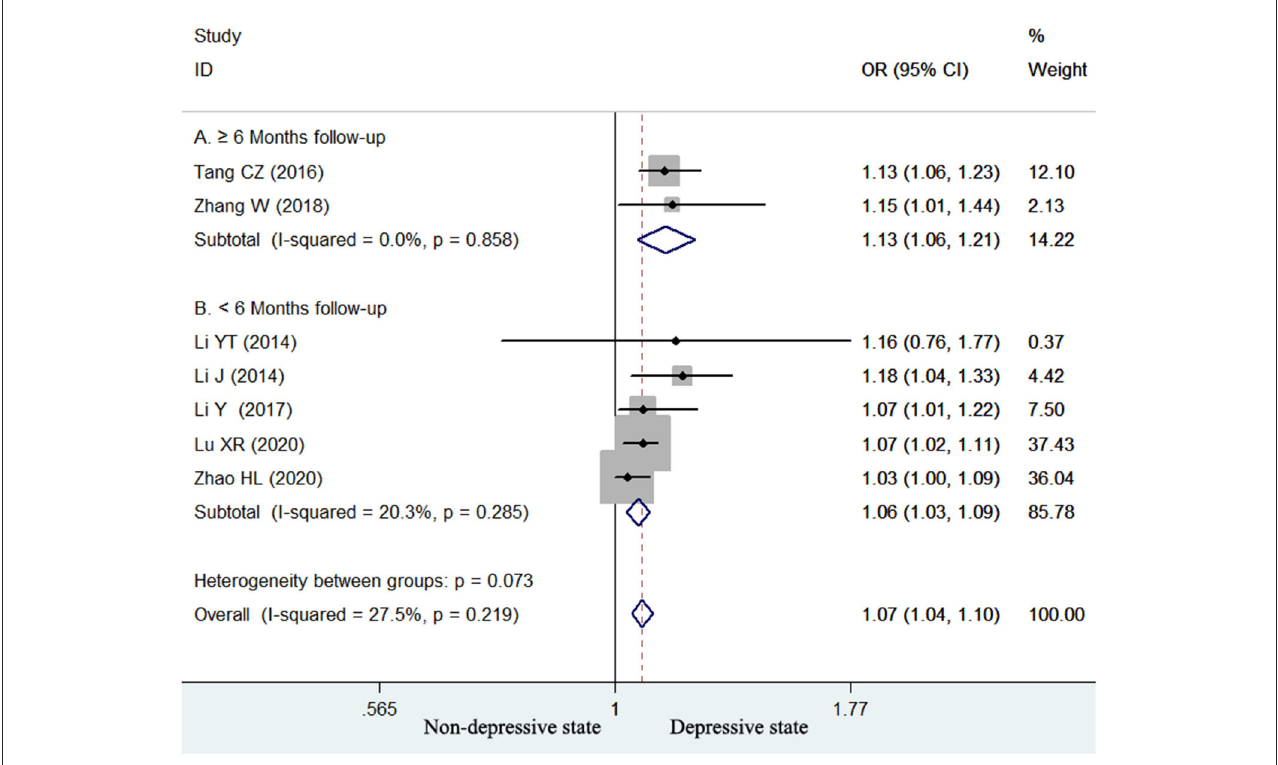
FIGURE4 Forest plots showing the pooled OR with 95% CI of poststroke depression for per unit increase in homocysteine level in a fixed-effect